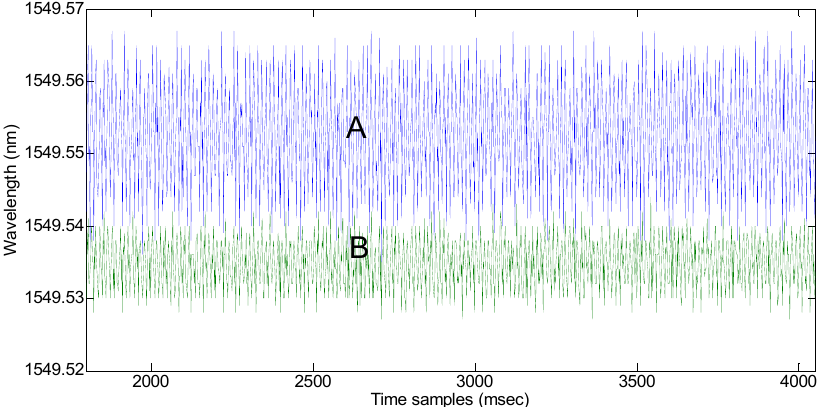
Figure 10. Time varying data of central wavelength position of FBG (beam 2) at two different locations along beam 1 due to the 80 Hz tone. The lower signal in the data is measured at position B and upper signal at position A, as shown in the schematic of Figure 3.